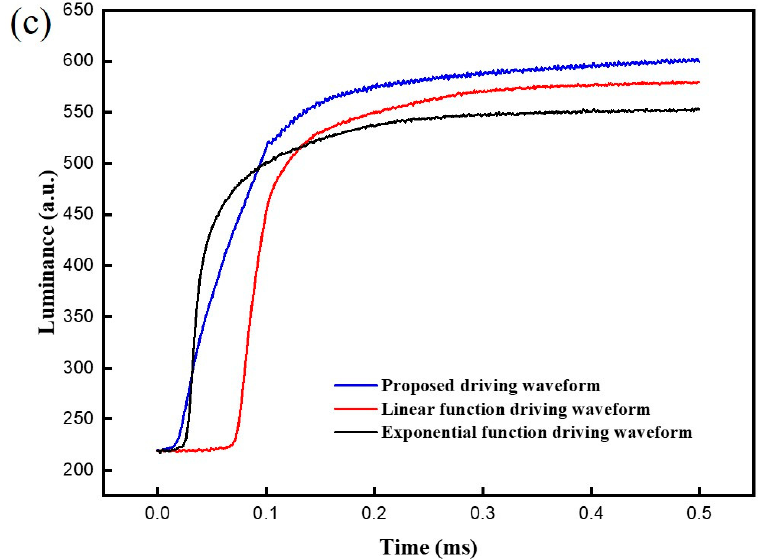
Figure 8. ( a ) Different driving waveforms for performance comparison. The blue line represents the proposed driving waveform; the red line the linear function driving waveform, and the black line the exponential function driving waveform. ( b ) The luminance driven by different rising times of the exponential function driving waveform and the linear function driving waveform. Luminance curves of the exponential function driving waveform and the linear function driving waveform were increased with the increase in rising time. ( c ) Luminance curves of different driving waveforms. The maximum luminance of the proposed driving waveform was 602.44, while the maximum luminance of the exponential function driving waveform and the linear function driving waveform were 579.97 and 553.81, respectively.